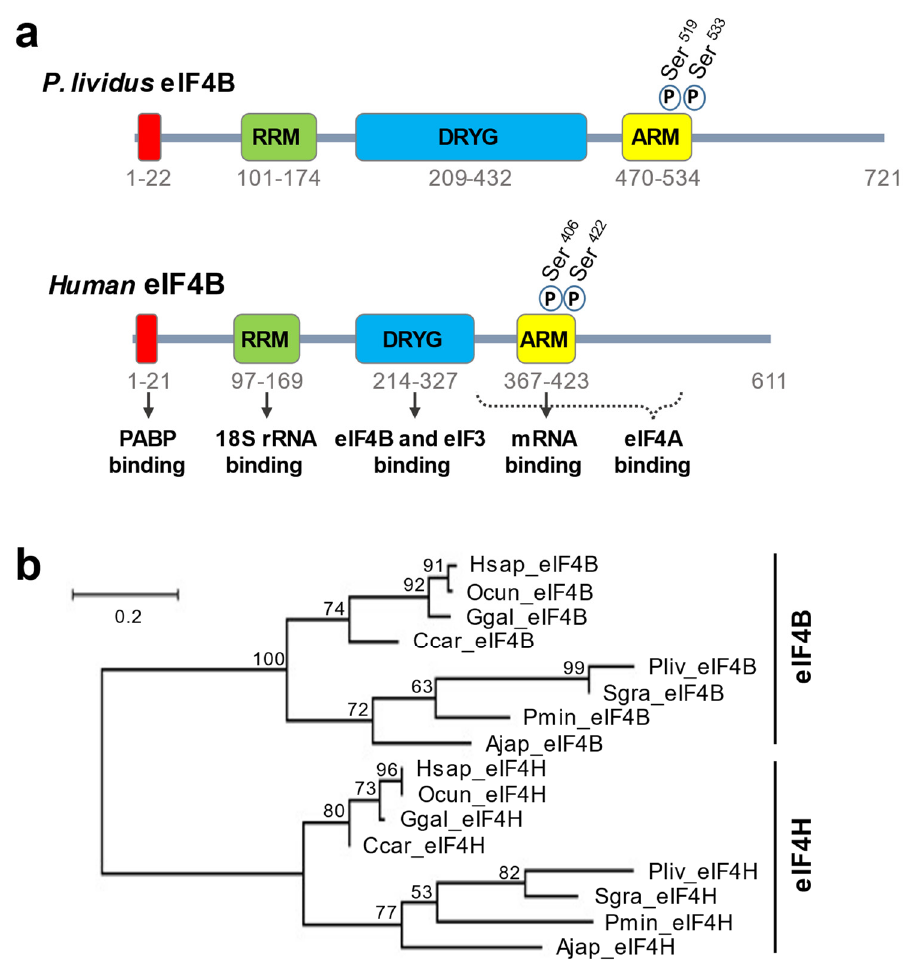
Figure 1. The P. lividus eIF4B protein presents four conserved functional domains and is the ortholog of human eIF4B. ( a ) Cartoon depicting the eIF4B protein of P. lividus and H. sapiens . The four con ‐ served regions with assigned functions in the vertebrate eIF4B appear as colored boxes (RRM, RNA recognition motif; DRYG, aspartic acid, arginine, tyrosine and glycine ‐ rich domain; ARM, arginine ‐ rich motif). The ARM motif harbors two consensus phosphorylation sites also present in the sea urchin homologs. ( b ) Maximum likelihood tree illustrating the phylogenetic relations between eIF4B and its paralog eIF4H. The tree was built with the amino acid sequence of vertebrate and echinoderm RRM domains using a JTT matrix ‐ based model [35], and 500 bootstrap replicates. Branch lengths are proportional to the number of substitutions per site. Bootstrap values are indi ‐ cated for each branch. RRM domains were found by the software SMART [36]. Hsap: Homo sapiens ; Pliv: Paracentrotus lividus ; Sgra: Sphaerechinus granularis ; Ocun: Oryctolagus cuniculus ; Ggal: Gallus gallus ; Ccar: Carcharodon carcharias ; Ajap: Anneissia japonica ; Pmin: Patiria miniata . We aimed to determine whether the sea urchin eIF4B protein can associate with an eIF4F complex. Our attempts to produce a polyclonal antibody against the sea urchin eIF4B protein were unsuccessful, and in our hands, no commercial antibodies against mammalian eIF4B cross ‐ reacted with their echinoderm orthologs. Still, we have demon ‐ strated that sea urchin eIF4B can interact in vitro with an eIF4F complex. For this, a P. lividus eIF4B protein showing the expected size (77.4 kDa) was produced in a rabbit retic ‐ ulocyte lysate. This lysate was then loaded onto a column of m 7 GTP ‐ sepharose beads, which retains eIF4E and its associated proteins (Figure 2a). The purification assay was performed in the presence of RNase A to exclude RNA ‐ mediated interactions. We observe that although eIF4E was effectively purified in all the conditions tested, the beads retained